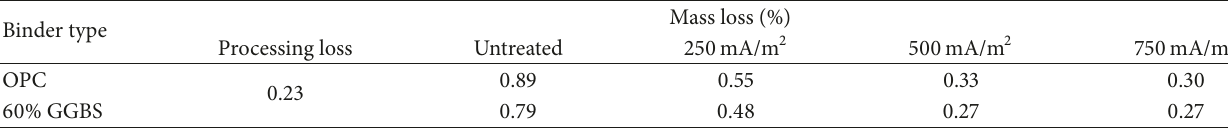
Table 4: Average of mass loss of steel arising from corrosion after galvanic cell monitoring depending on the applied current density and binder type.